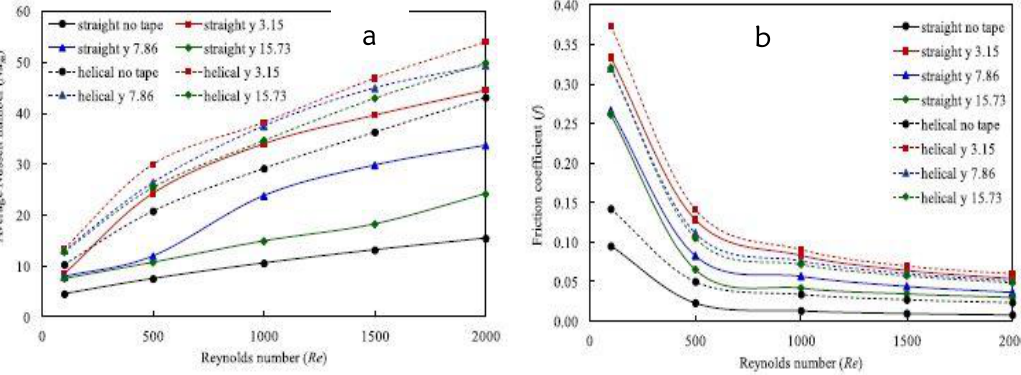
Figure 9: (a) Average Nusselt number of water flow for various configurations at T wall = 333.15 K. (b) Friction coefficient of water flow for various configurations at T wall = 333.15 K